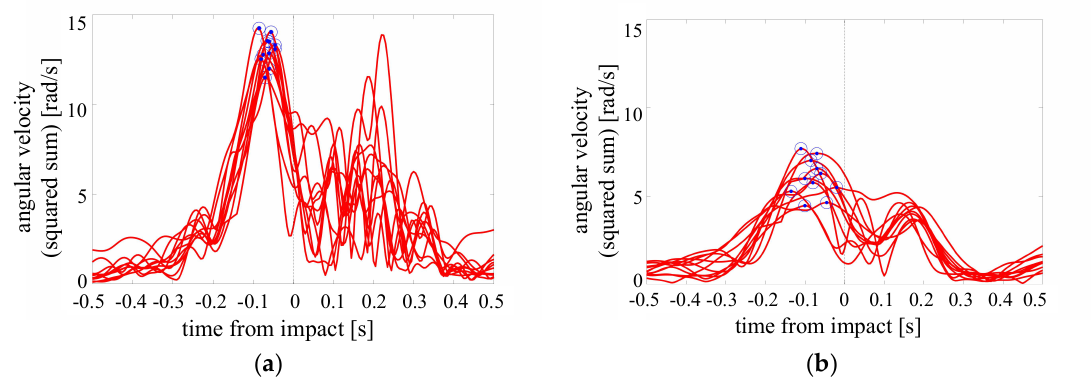
Figure 7. ( a ) Trajectories of angular velocity of man beginner aligned at impact time in toss batting; ( b ) Trajectories of angular velocity of woman beginner aligned at impact time in toss batting. Each blue dot shows the detected peak of angular velocity in each